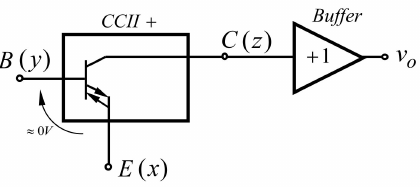
Figure 2. Symbol representation of four-terminal CFOA, in which the CCII+ is drawn as an equiva- lent